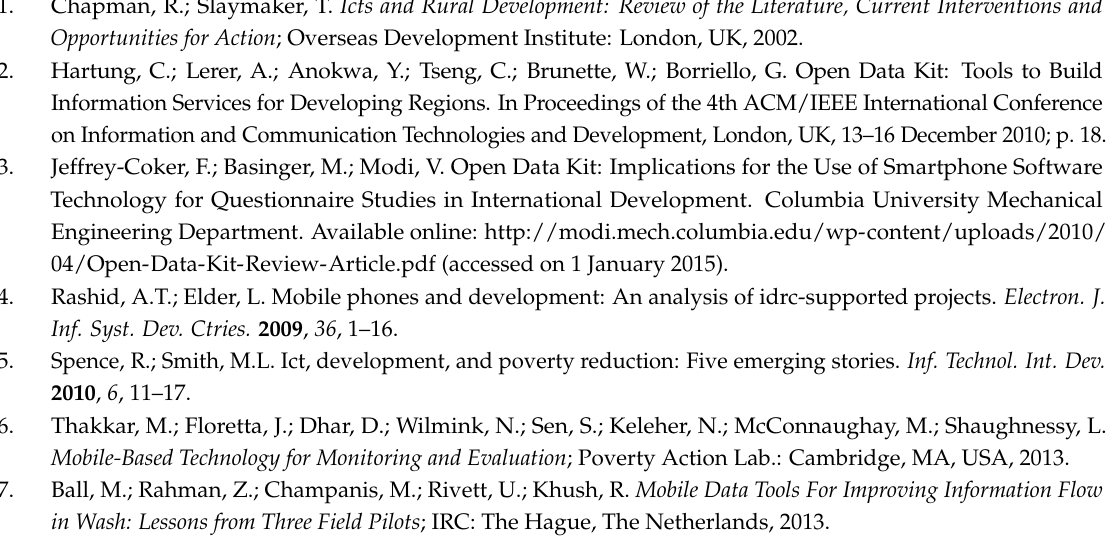
Figure S1: MST User Survey, Figure S2: Data Management Value Chain, Table S1: MST Evaluation Questionnaire, Table S2: Standard Evaluation Survey, Table S3: Detailed Definitions of Survey Applications, Worksheet S1: Calculator for weighted ranking of tested